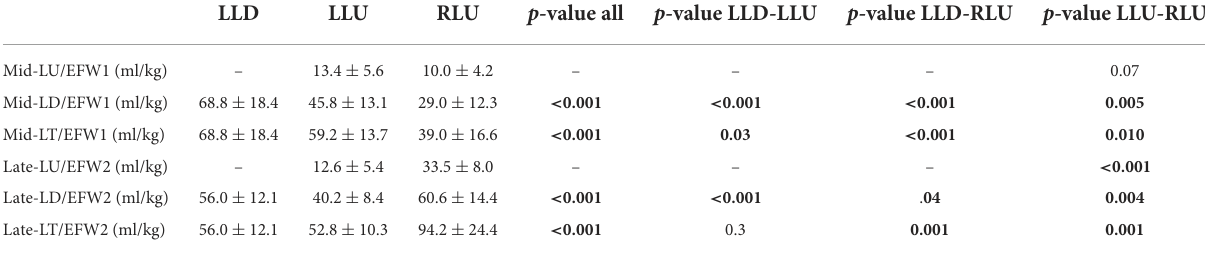
Tablecomparesclinicalcharacteristics,ofstudypopulationgroups. TABLE 2 Liver volumes in right-sided CDH lower in mid-gestation and higher in